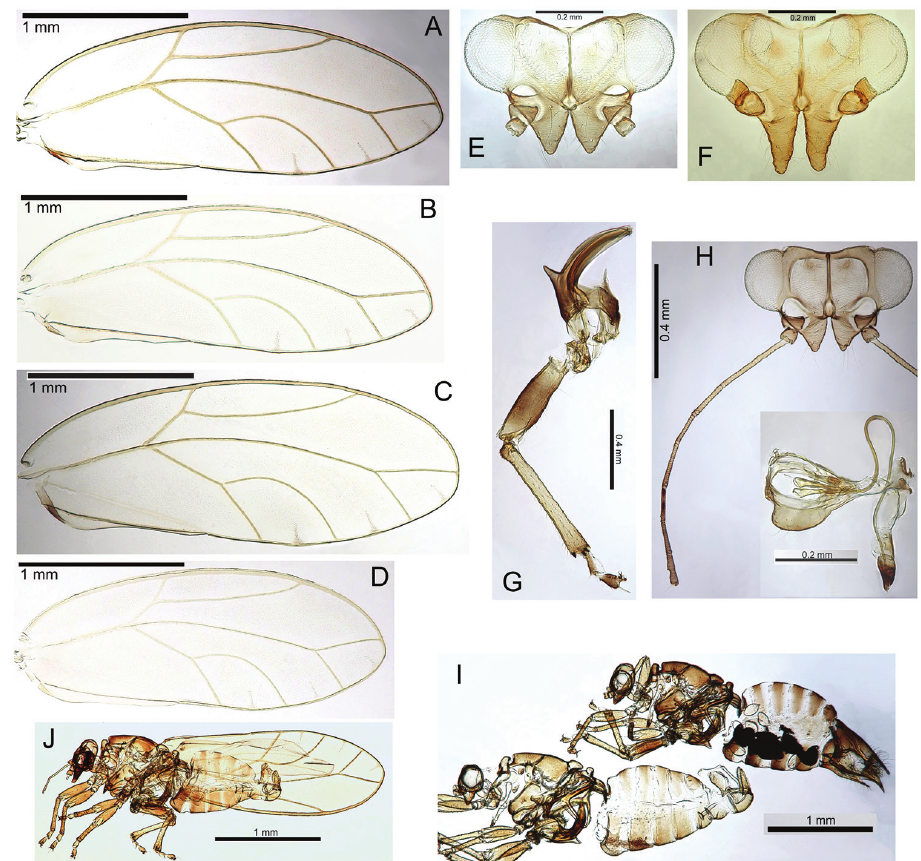
Figure 34. Pariaconus ohiacola . A, B, C, D fore wing: A form ohiacola B form angustipterus C form obtusipterus D form waianaiensis E, F head: E form ohiacola F form waianaiensis G, H, I form ohiacola : G hind leg H head and antenna with proboscis (inset) I male and female J male, form waianaiensis .